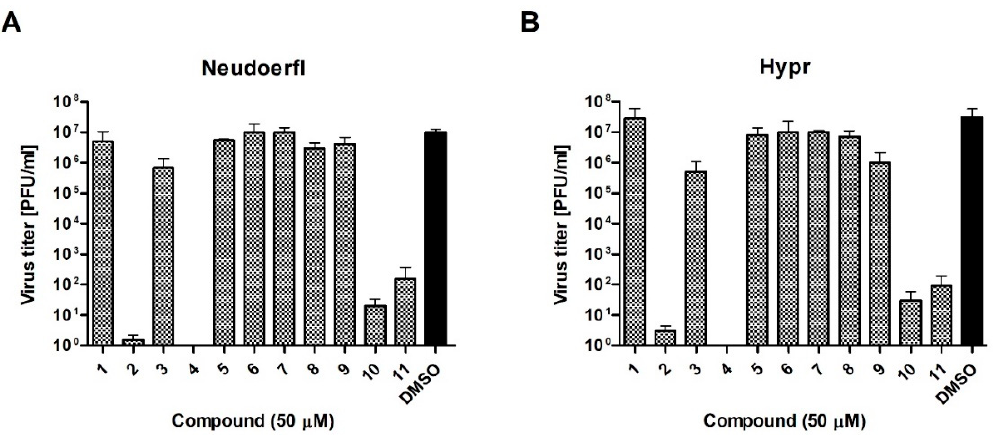
Figure 4. The effect of synthesized compounds on Neudoerfl and Hypr TBEV titers in A549 cells. A549 cells were infected with TBEV Neudoerfl ( A ) or Hypr ( B ) strain at an MOI of 0.1 and treated with 50 µM of compounds. At 72 h p.i., the supernatants were collected and viral titers were determined by the plaque assay. Error bars indicate standard deviations from three experiments.